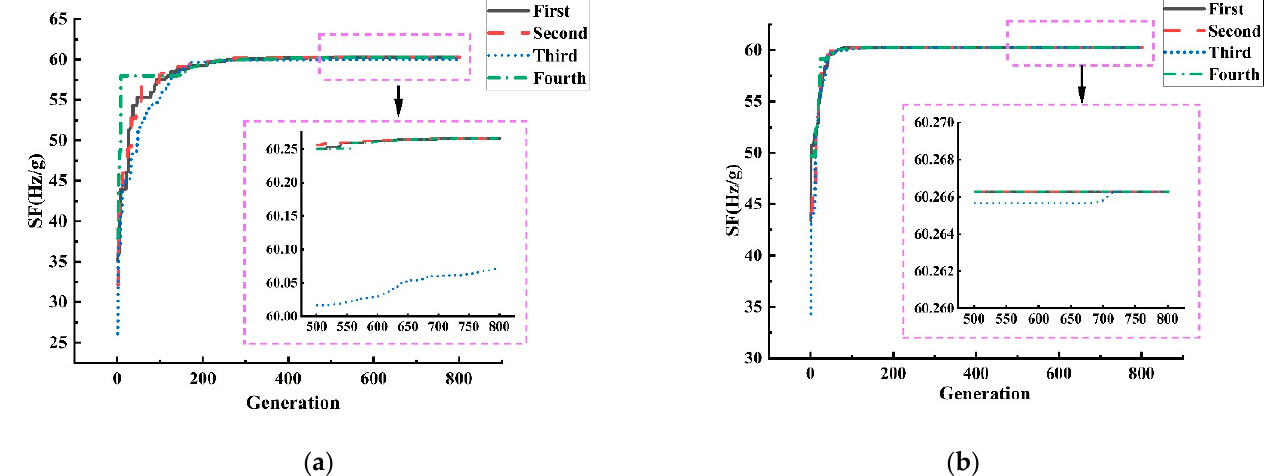
Figure 3. Comparison of optimization of two algorithms. ( a ) ordinary DE algorithm. ( b ) SAPRDE algorithm.